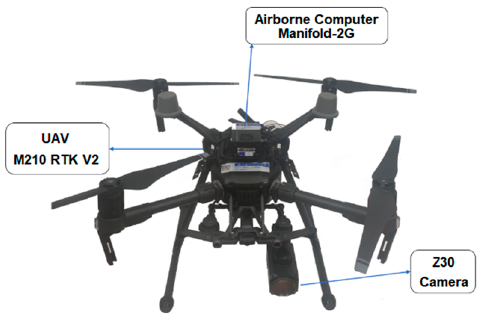
Figure 9. Experimental UAV platform.